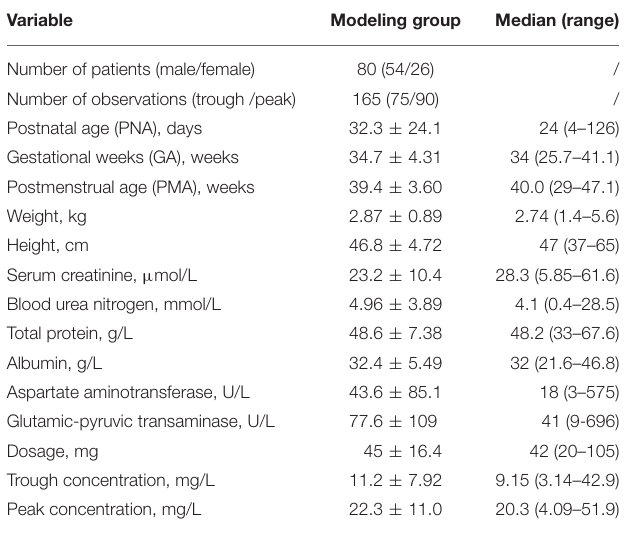
TABLE 1 | Demographic and clinical data for neonates in this